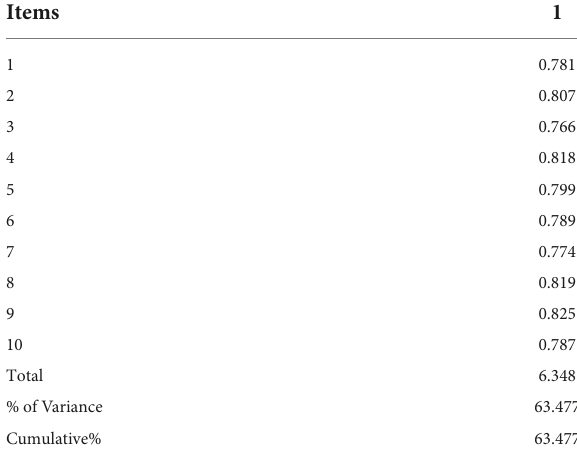
TABLE 2 Saturations of the items of the climate values (CV) questionnaire by principal component